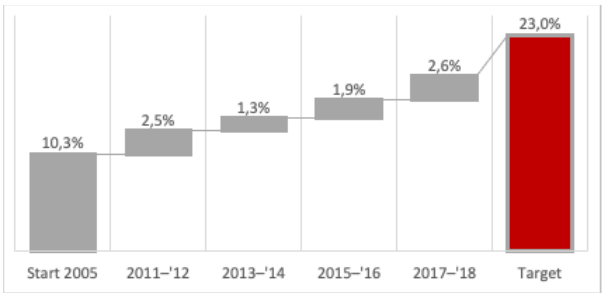
Figure 12. France—energy consumption trend. Source: https://ec.europa.eu/eurostat/web/energy/ data/shares, accessed on 28 June 2021.